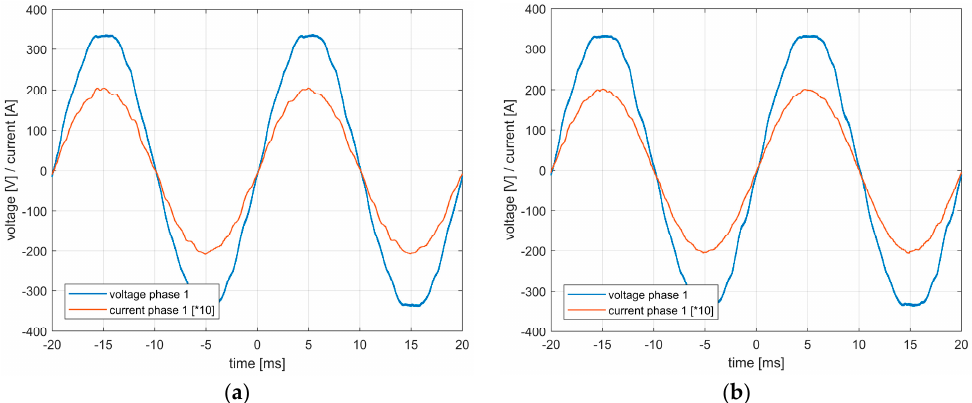
Figure 14. Experimental results with different controller structures and low distorted grid voltage (Scenario 1): ( a ) PR controller; ( b ) PMR controller. Table 3. Harmonic current distortion obtained with the different control